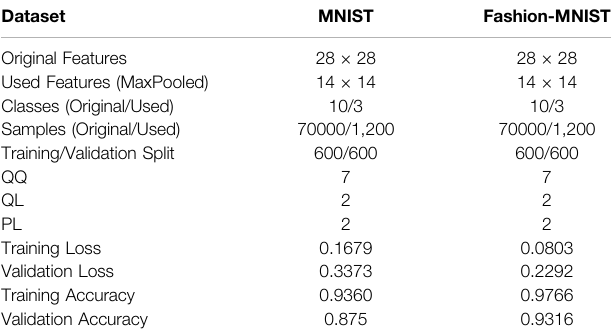
TABLE 2 | QNet performance on truncated MNIST and Fashion-MNIST datasets after 10 training